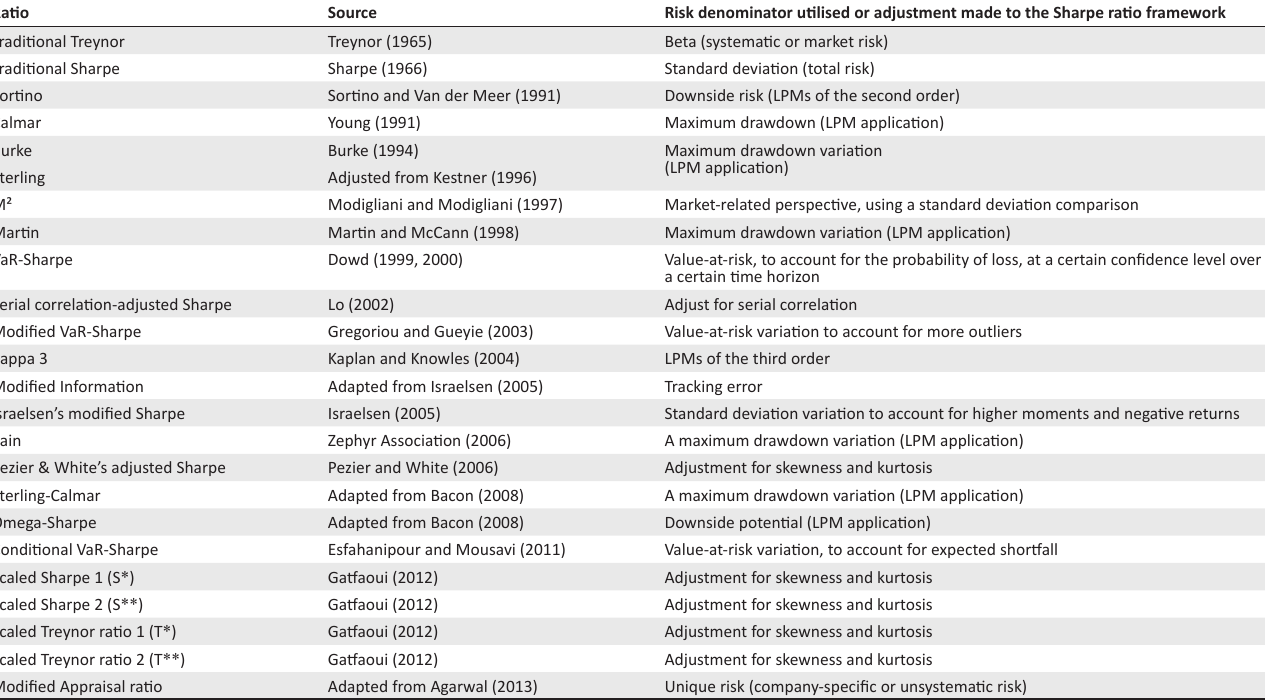
TABLE 1: Summary of risk-adjusted performance